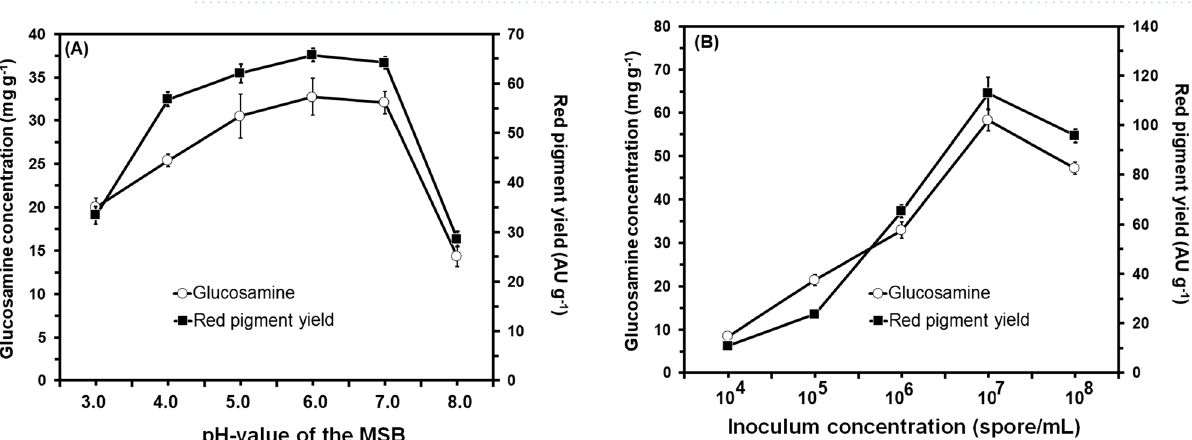
Figure 3. Effect of different incubation temperatures ( A ) and effect of different incubation periods ( B ) on growth (mg g −1 ) and red pigments production (AU g −1 ) by Monascus ruber SRZ112 under SSF. Initial pH of the MSB moistening agent was adjusted to 6.0 using 1 N NaOH and HCl. Solid–state grown cultures were carried out on potato peel. All data are shown as the mean ± SD of triplicate measurements from two independent experiments.